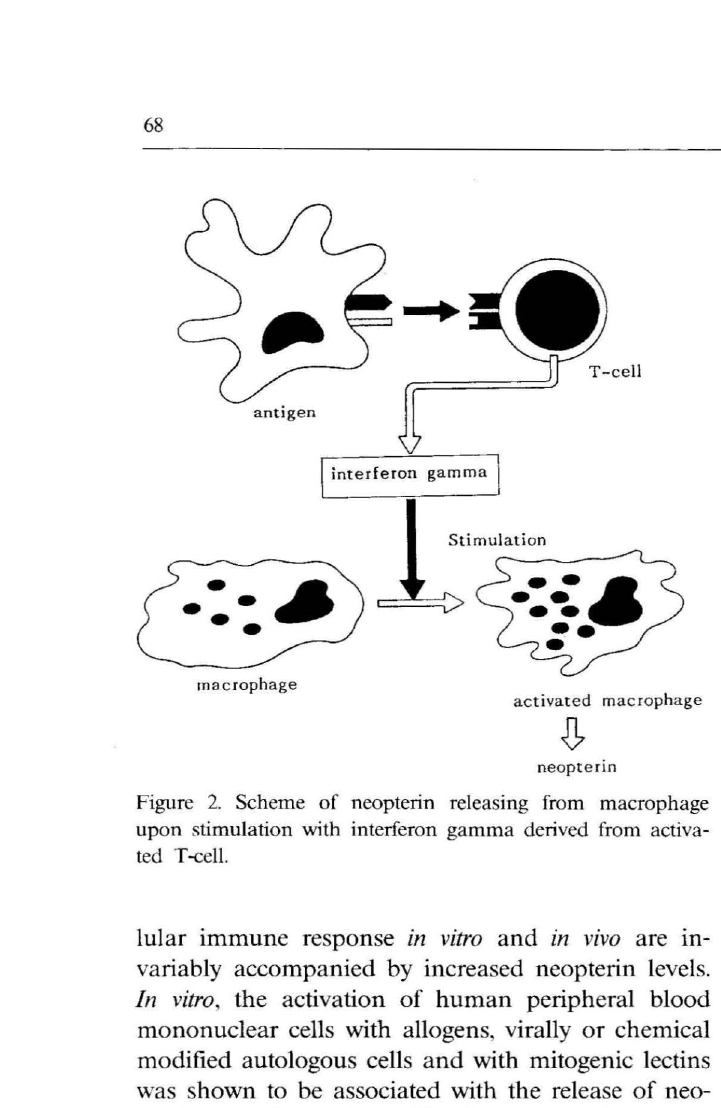
Figure 2. Scheme of neopterin releasing from macrophage upon stimulation with interferon gamma derived from activa ted